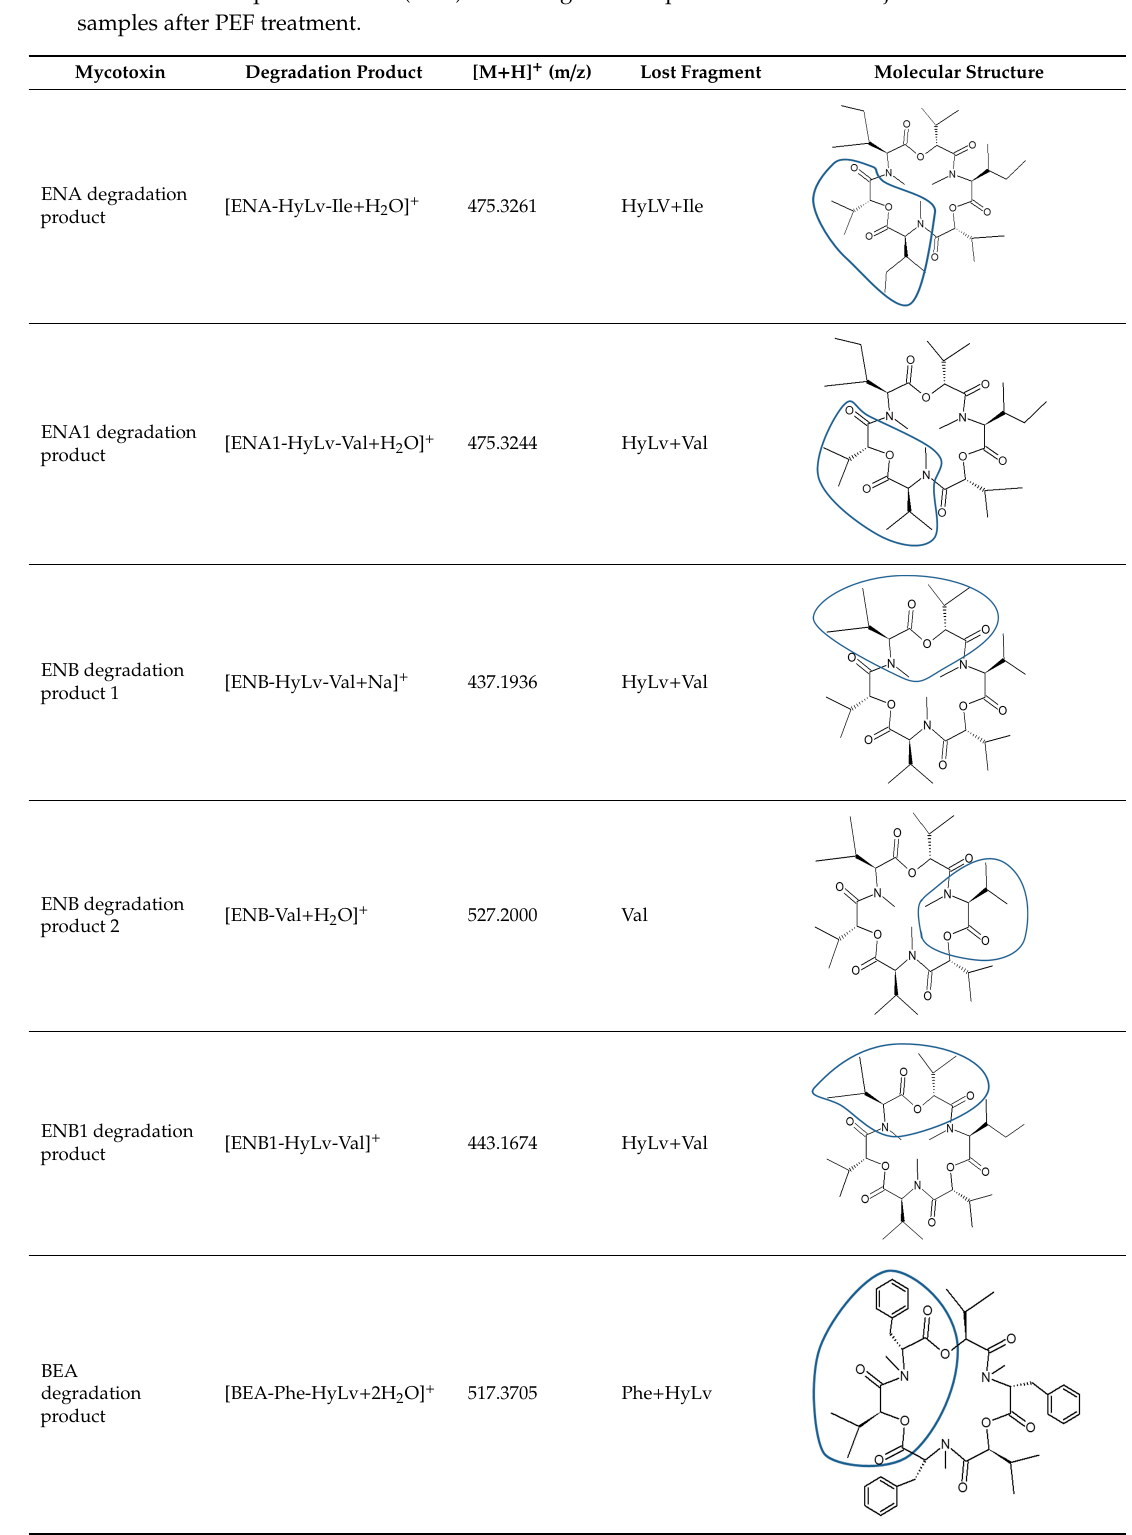
Table 1. LC-ESI-qTOF-MS data (MS1) of the degradation products obtained in juice and smoothie samples after PEF treatment.